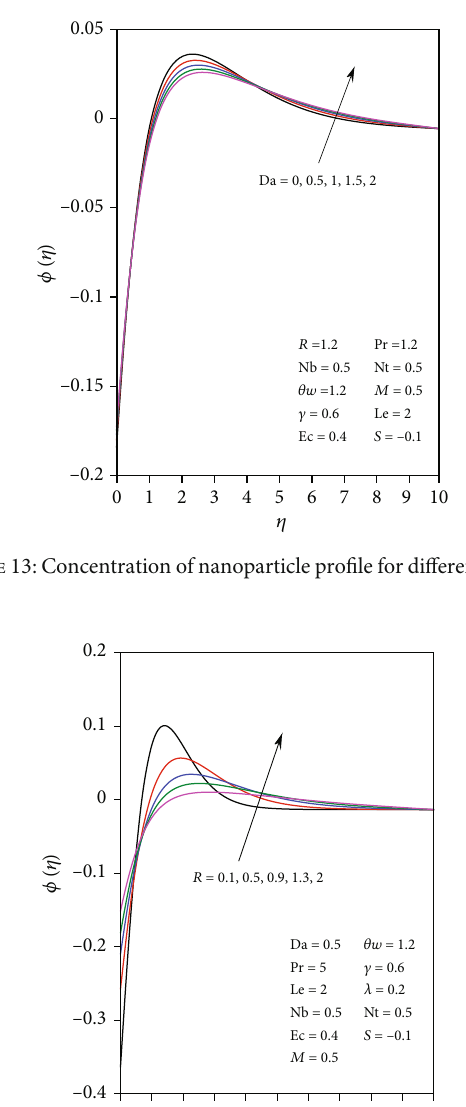
Figure 12: Concentration of nanoparticle pro fi le for di ff erent values of Pr .